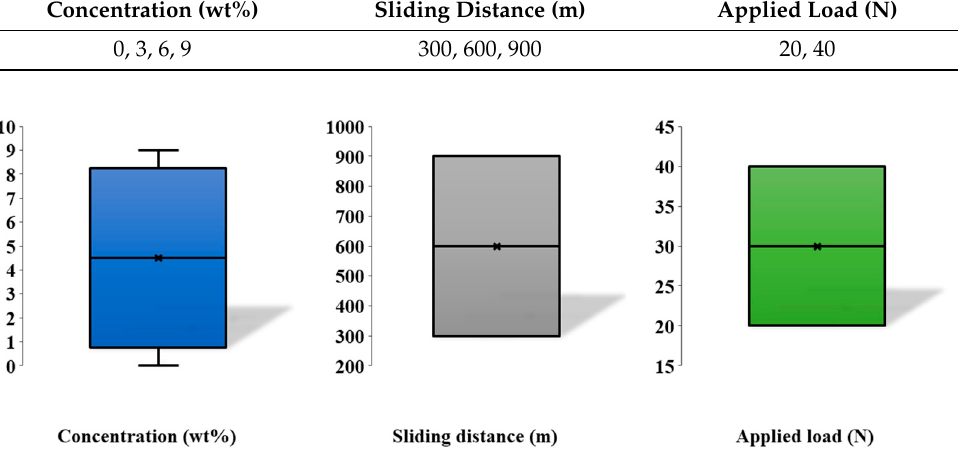
Figure 2. Box plot of the experimental data.